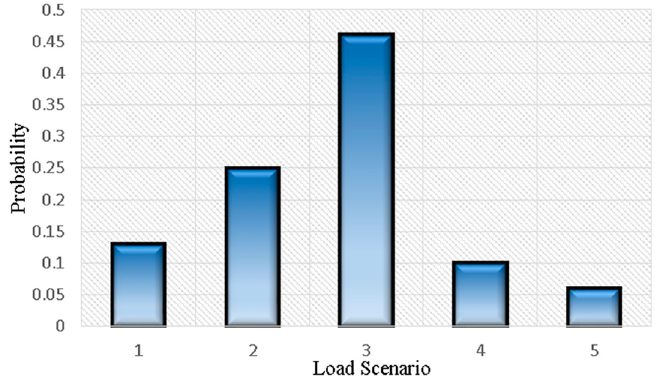
Figure 4. Probability distribution of customers’ load scenarios.